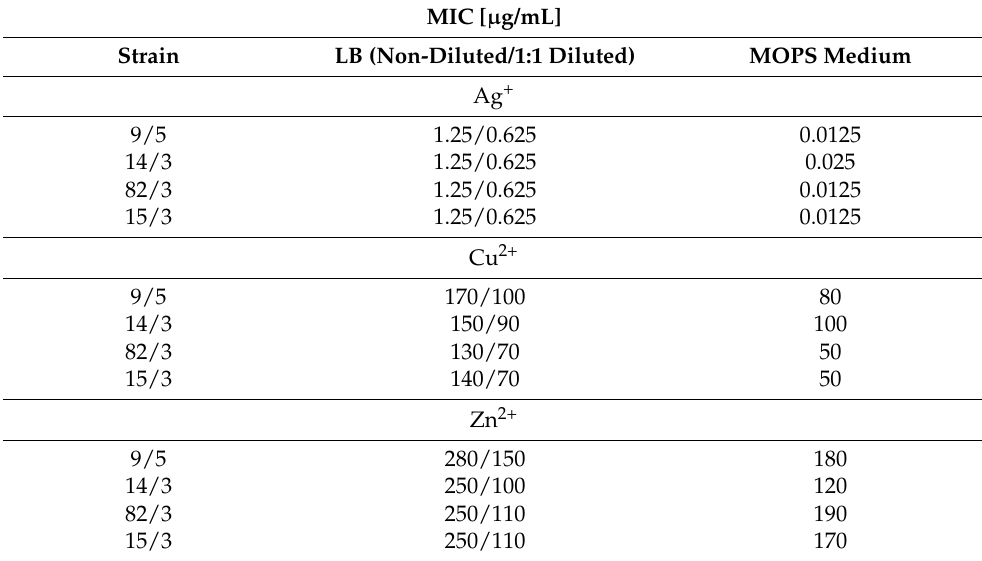
Table 2. MIC of Ag + , Cu 2+ , Zn 2+ ions in chosen media against P. aeruginosa clinical